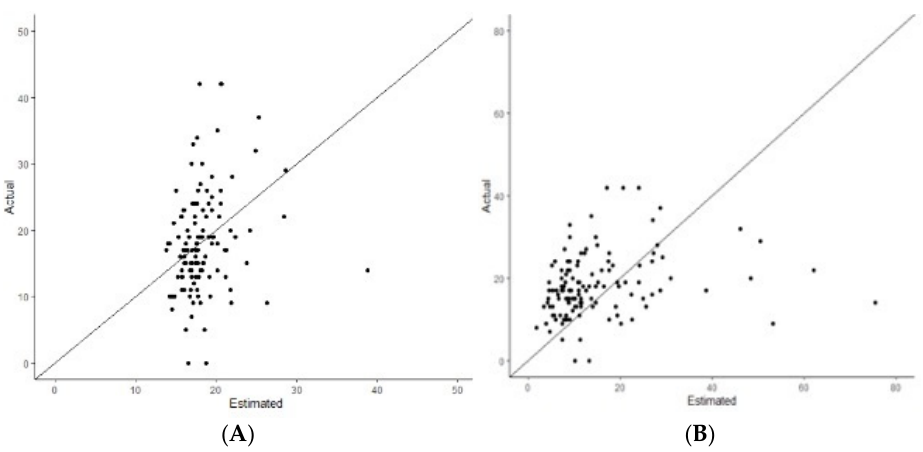
Figure 1. Calibration plots for the nomogram models illustrating the predicted probability for ( A ) recurrence score as a continuous outcome, and ( B ) as a binary outcome for recurrence score ≤ 25 and >25.